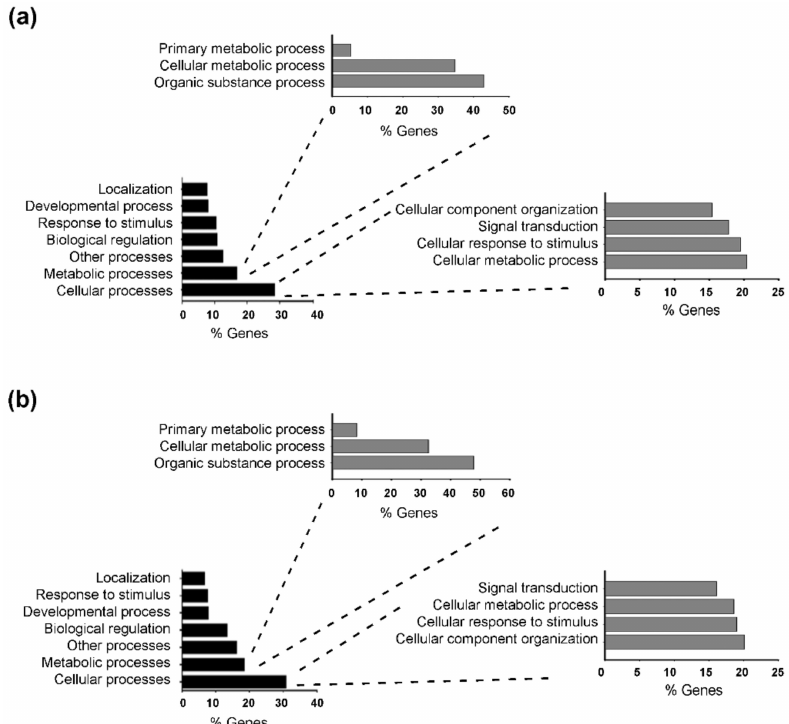
Figure5. StarvationandT3globallya ff ectsimilarbiologicalprocesses. ( a )Geneontologyclassificationof the biological processes most a ff ected by starvation in skeletal muscles. ( b ) Gene ontology classification of the biological processes most a ff ected by T3 in STVT3 skeletal